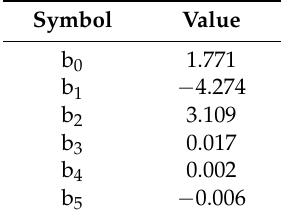
Table 10. Estimated coefficients for estimating load factor from Finnmarken data.